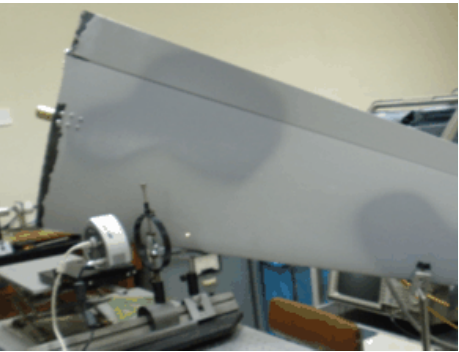
Figure 4. Experimental plot of the correlation C versus displacement (in μ m) of the CCD camera. Notice that the maximum is reached away of the first exposure where the camera was not yet displaced.